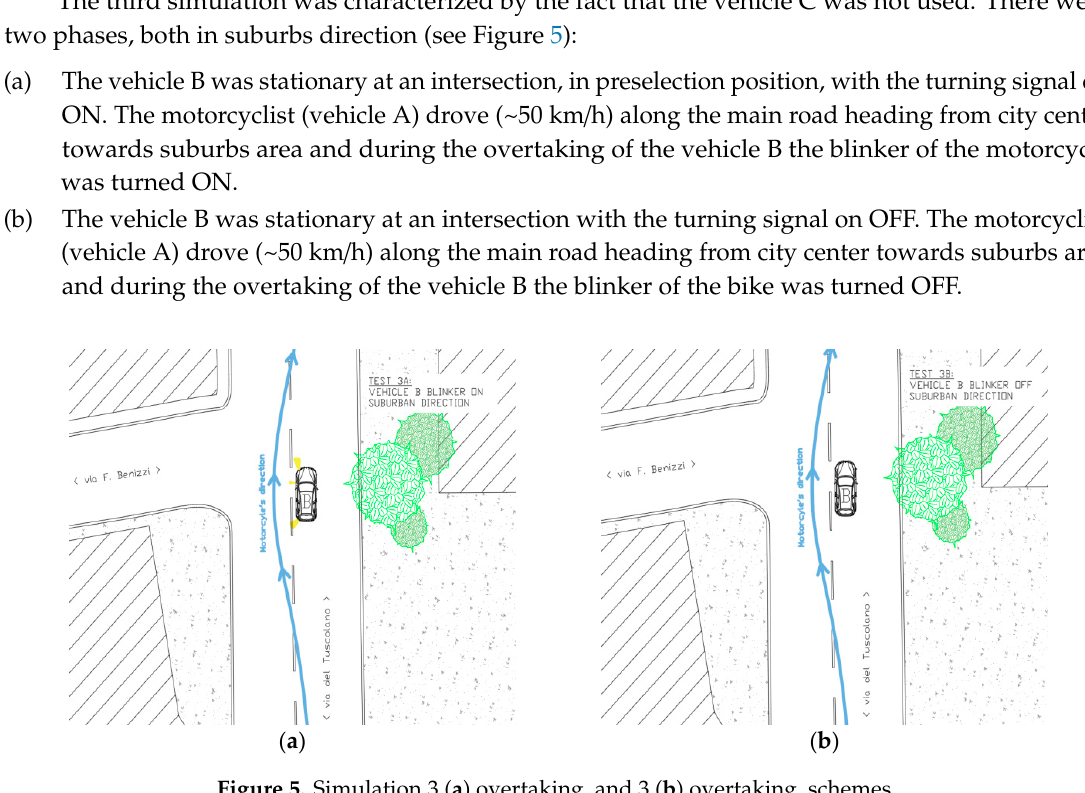
Figure 4. Simulation 2( a ) overtaking, and 2( b ) going through, schemes.